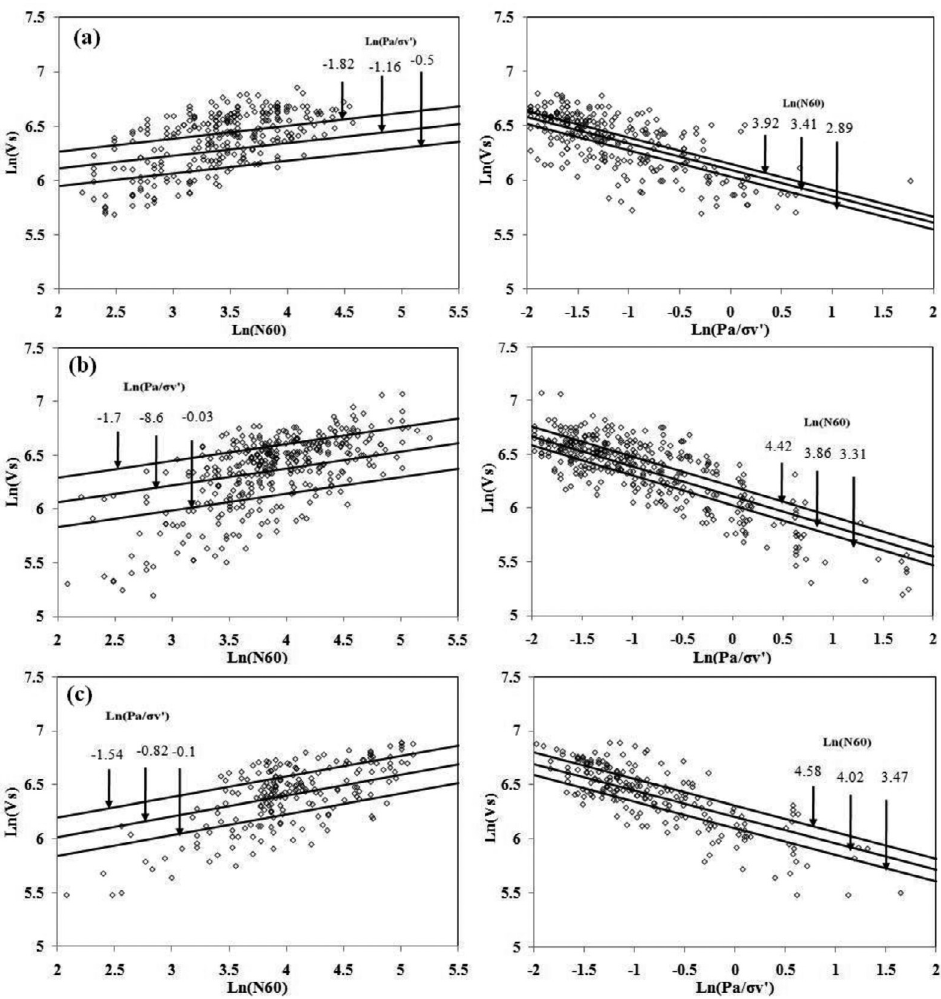
Figure 6. Graphical form of regression equations for (a) fine grain soil, (b) sandy soils and (c) gravely soils, With trend lines corresponding to the mean and mean plus and minus of Ln and Ln ( N